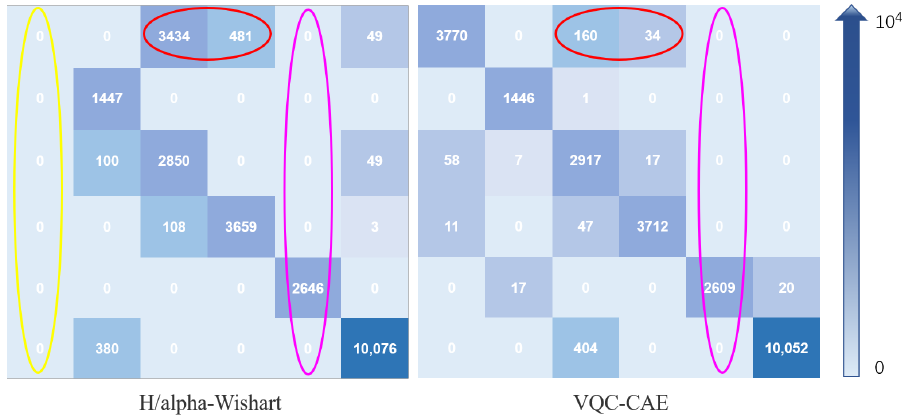
Figure 10. Experimental data of the Flevoland area, ground truth of the ground object and classifica- tion results by the proposed method and comparison method. Ellipse A, Rectangles B and C are the specific comparative analysis areas of the classification maps in ( c – e ). ( a ) Pauli pseudo color image synthesized by the polarimetric coherence matrix T. ( b ) The ground truth of the three objects. ( c ) The classification result of H/alpha-Wishart. ( d ) The classification result of the VQC-CAE model. ( e ) The classification result of the VQC-CAE model without Gaussian smoothing loss. ( f ) The color set of the ground truth: light blue for peas, navy blue for Lucerne, pink for beet, orange for potatoes, brown for soil, light green for wheat, and the unlabeled pixels are black.